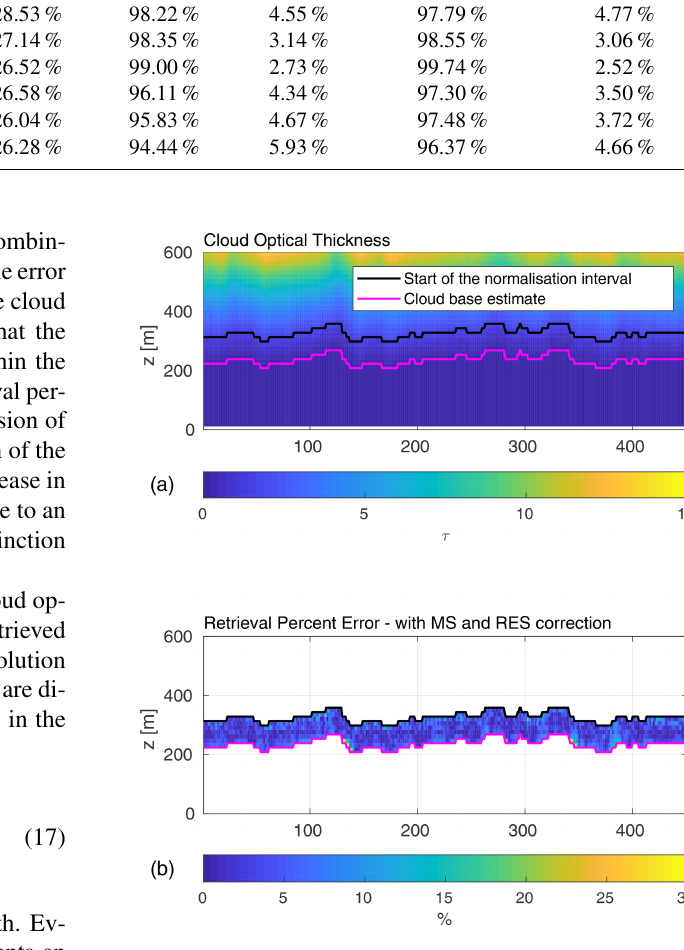
Figure 5. Cross section of the cloud optical thickness (a) and re- trieval percent error of the cloud optical extinction retrieved with the multiple scattering and range resolution correction (b) . The ma- genta line in both panels represents the estimated height of the cloud base, and the black line is the beginning of the normalisation inter-